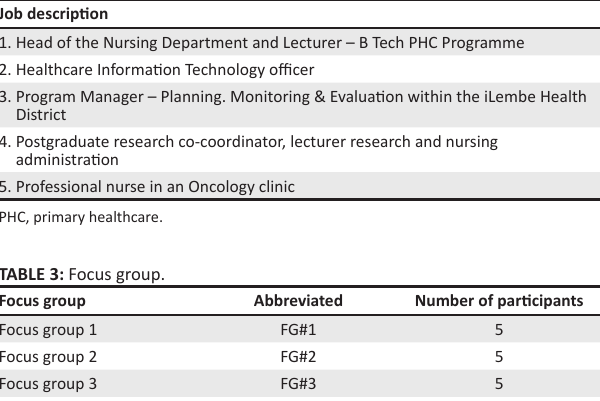
TABLE 2: Job description of the